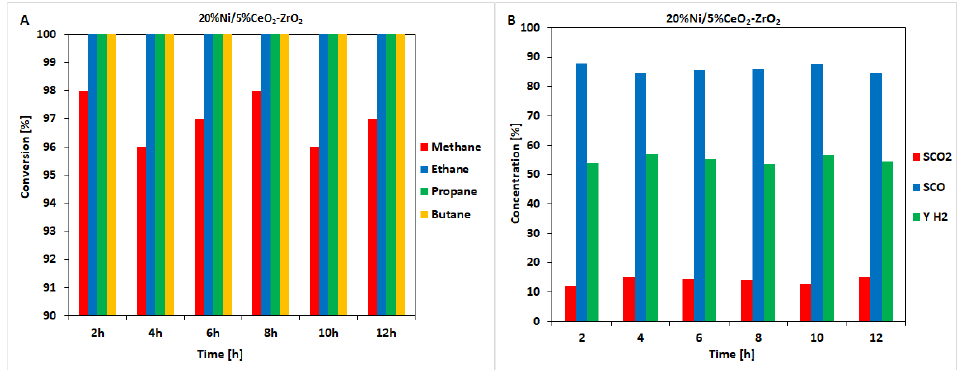
Figure 8. Results of the time-on-stream catalytic tests performed during 12 h of the OSRM of the LNG reaction on a 20%Ni / 5%CeO 2 -ZrO 2 catalyst. ( A ) Hydrocarbon conversion. ( B ) The selectivity of the CO and CO 2 and hydrogen yield.